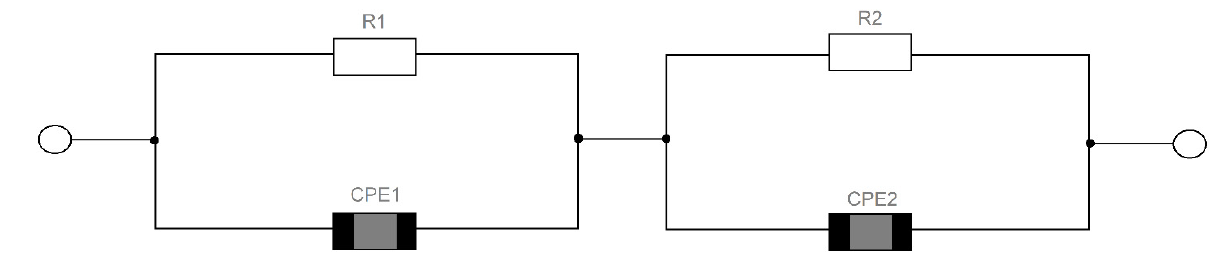
Figure 11. Equivalent circuit used to represent the electrical properties of pure and modified BLT4 ceramics.